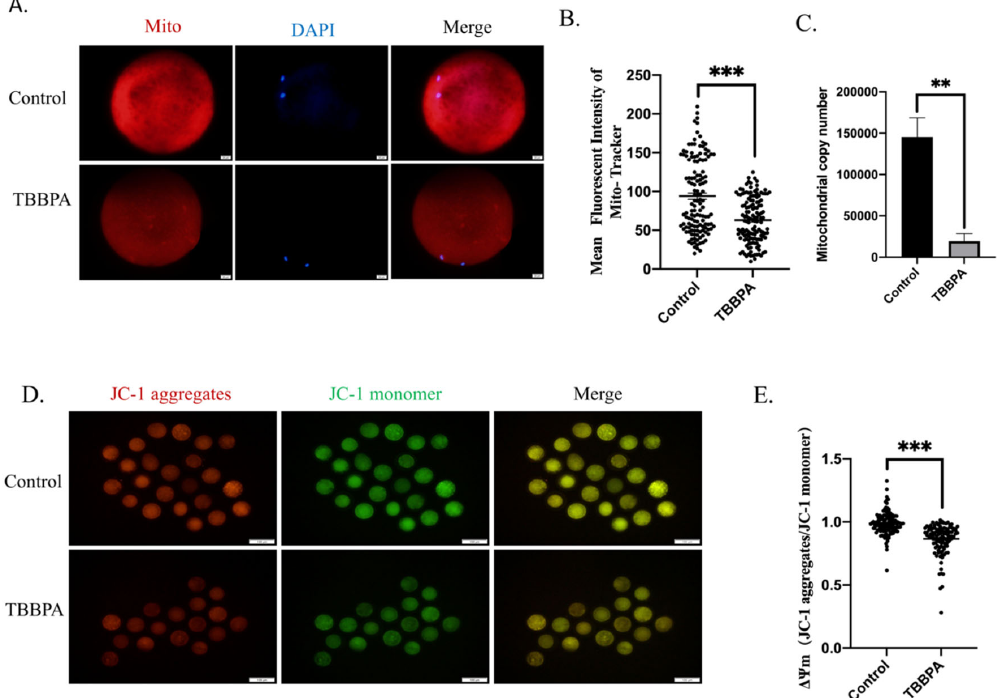
Figure 4. Effects of TBBPA on mitochondrial function in oocytes: ( A ) Representative images of mitochondria in each group. Ex/Em, 529/590. Scale bar = 20 µ m. ( B ) Mean fluorescent intensity of Mito-Tracker. Control, n = 134; TBBPA, n = 138. ( C ) mtDNA copy number was measured. ( D ) Mitochondrial membrane potential after TBBPA treatment. Ex/Em,: 488/530nm; Ex/Em, 529/590. Scale bar = 20 µ m. ( E ) ∆Ψ m after TBBPA treatment (JC-1 aggregates/ JC-1 monomer). Control, n = 124; TBBPA, n = 116. ** p < 0.01, *** p <